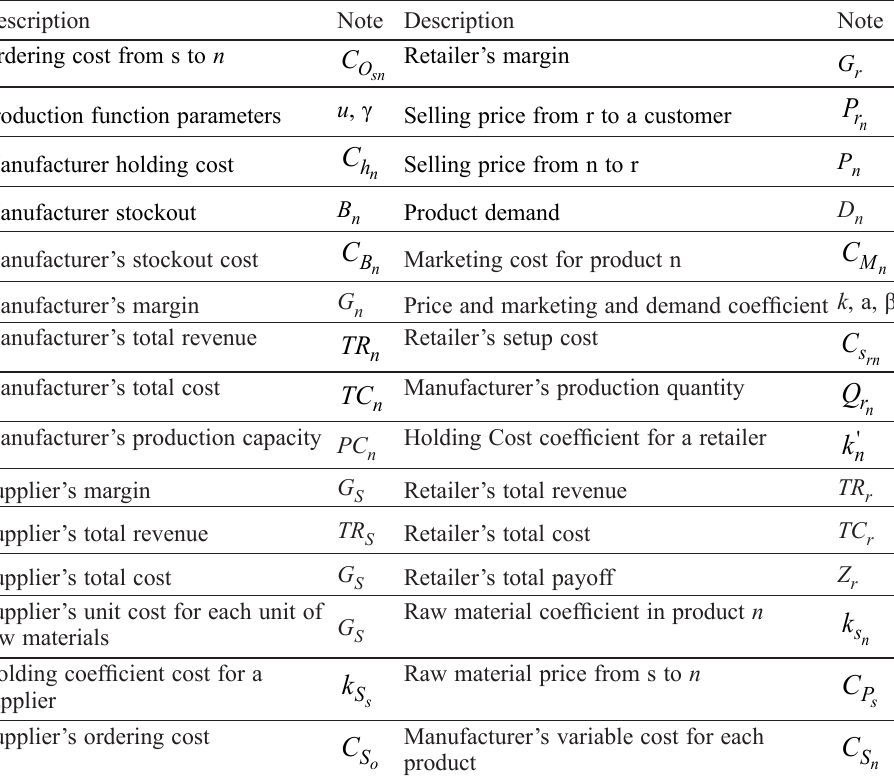
Table 1. Variable and